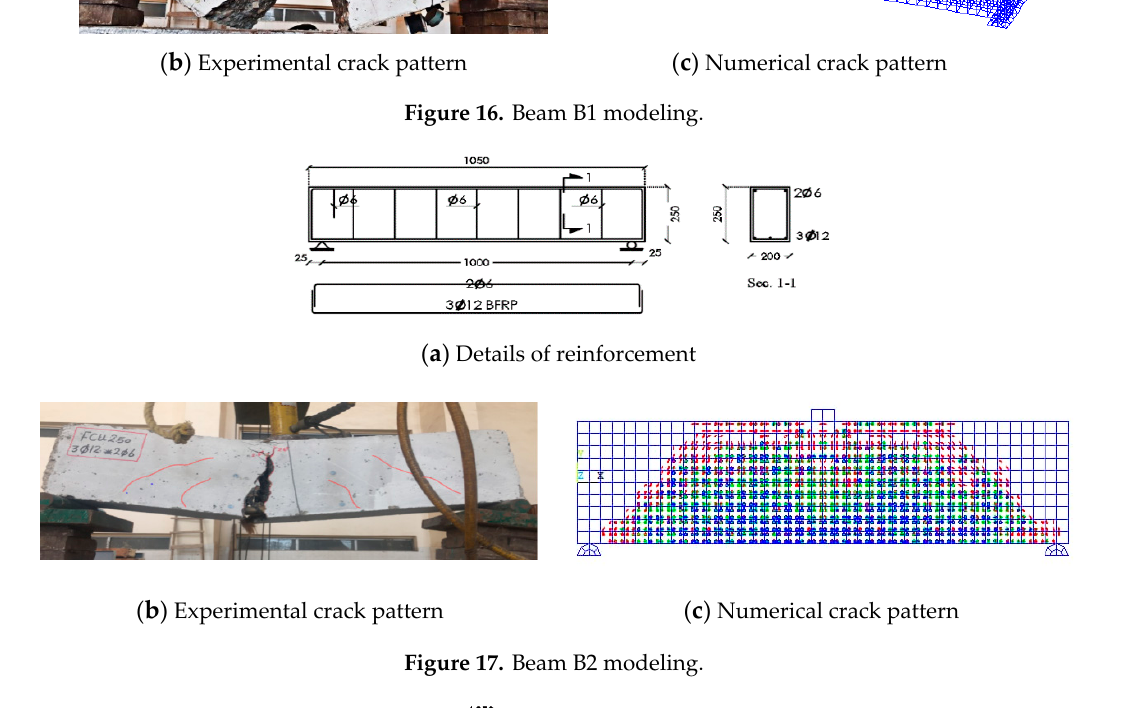
Figure 16. Beam B1 modeling.